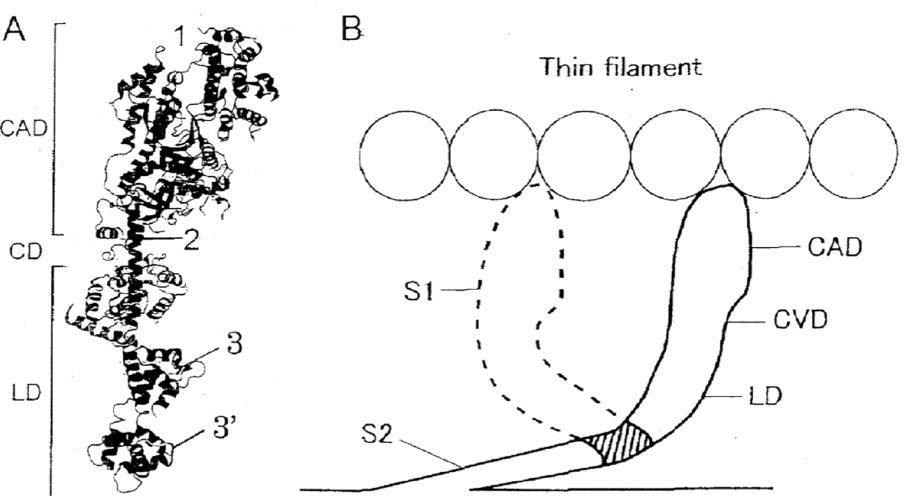
Figure 10. Schematic diagrams showing change in myosin head configuration before and after power stroke. (A) Ribbon diagram of the myosin head showing approximate regions of attachment of anti-CAD, anti-CVD and anti-LD antibodies, indicated by numbers 1, 2 and 3 and 3 9 , respectively. (B) Myosin head configurations before and after power stroke, indicated by solid and broken lines, respectively. Note rotation of the LD around the LD-S2 junction (shaded area) as well as rotation of the CAD around the CVD.